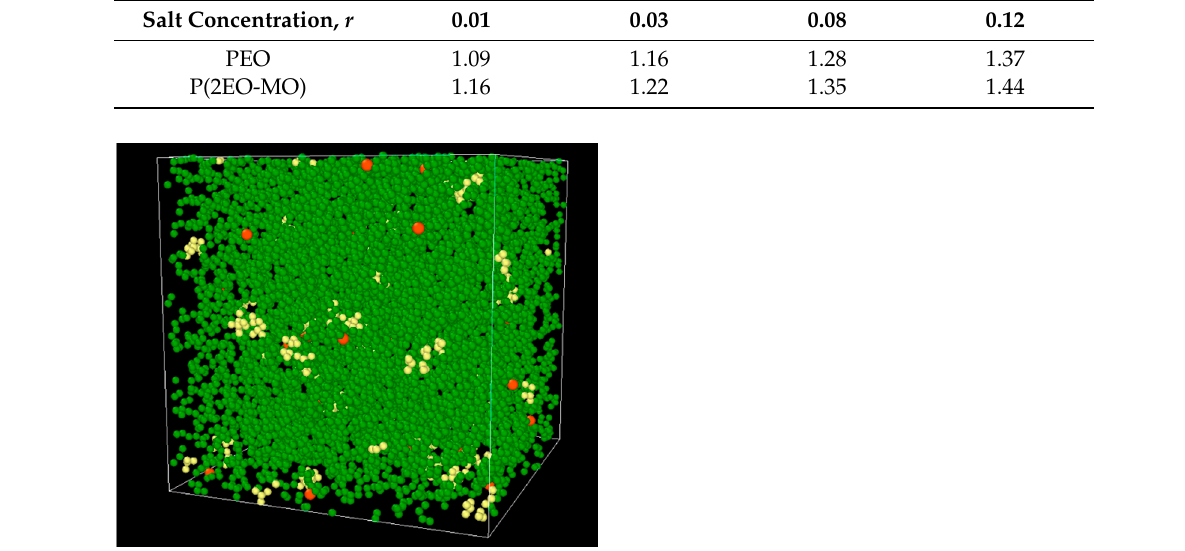
( b ) Figure 4. Radial distribution function between Li ions and N atoms of TFSI ions at various salt con- centrations for ( a ) PEO and ( b ) P(2EO-MO). From these results, it can be seen that the Li ion always has a strong bond with the TFSI ions and/or the oxygen atoms of the polymer. Because the oxygen coordination struc- ture is important for the transport of Li ions by inter/intra-hopping, the results for the oxygen coordination rate under each condition were obtained, as shown in Figure 5. Here, the oxygen coordination rate β of Li ions is defined as the fraction of Li ions coordinated by oxygen atoms of five or more macromolecules among all Li ions. From the figure, it can be seen that the coordination rate decreases as the salt concentration increases. This trend is due to the LiTFSI salt formation at a high salt concentration and the decrease in the coordination number with the oxygen atoms.